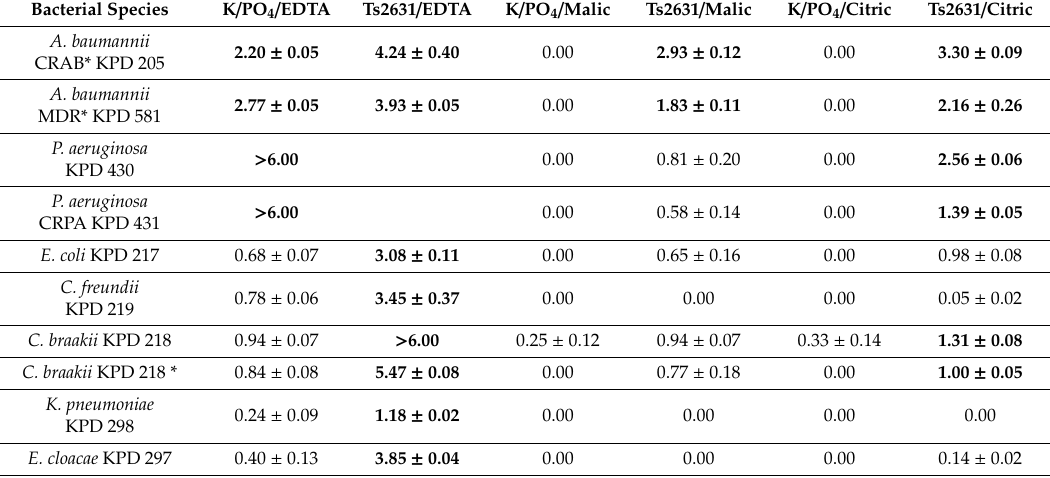
Table 2. Combined bactericidal activity of the Ts2631 / outer membrane permeabilizers (EDTA, citric and malic acid) against several Gram-negative multidrug-resistant (MDR) bacterial pathogens. The significant log reduction units observed ( ≥ 1 log kill) are marked in bold. Bacterial Species K / PO 4 / EDTA Ts2631 / EDTA K / PO 4 / Malic Ts2631 / Malic K / PO 4 / Citric Ts2631 /